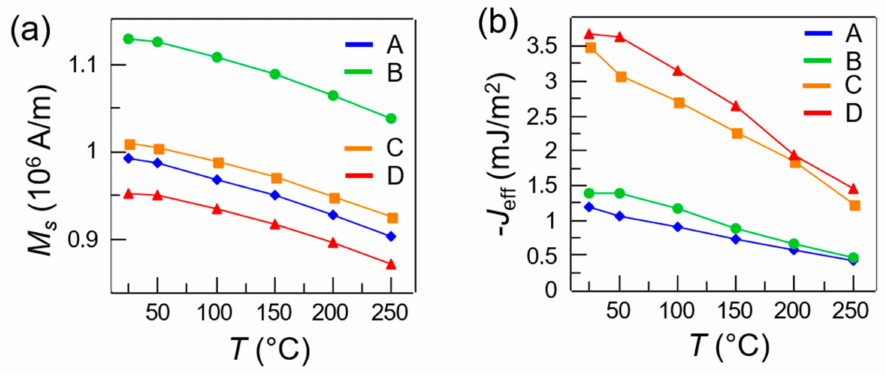
Figure 5. ( a ) Saturation magnetization M s as a function of temperature for set A–D (color-coded); ( b ) Coupling strength J e ff as a function of temperature for set A–D